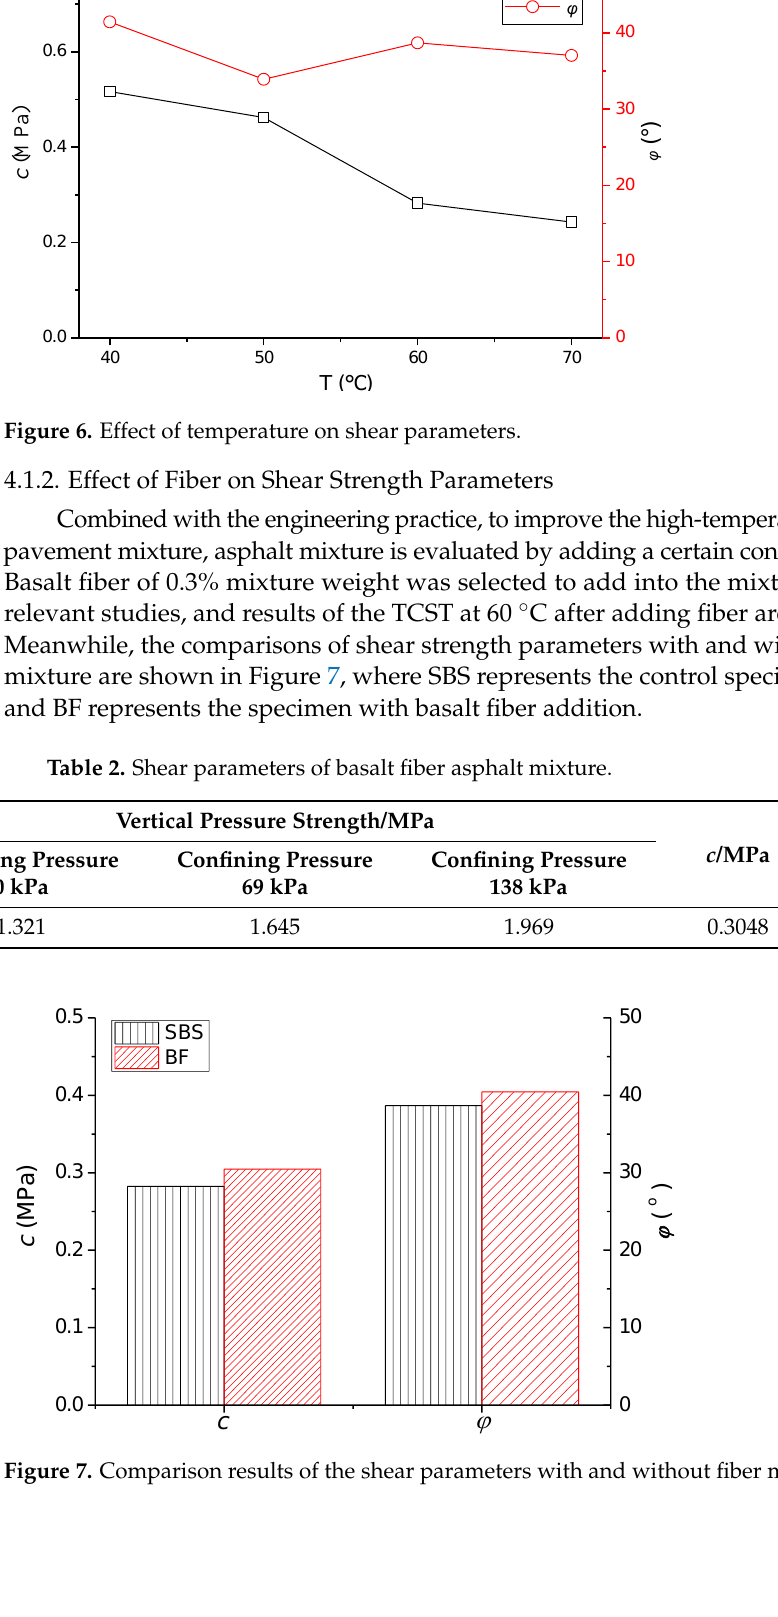
8 of 21 Table 1. Shear parameters of SBS asphalt mixture at different temperatures.